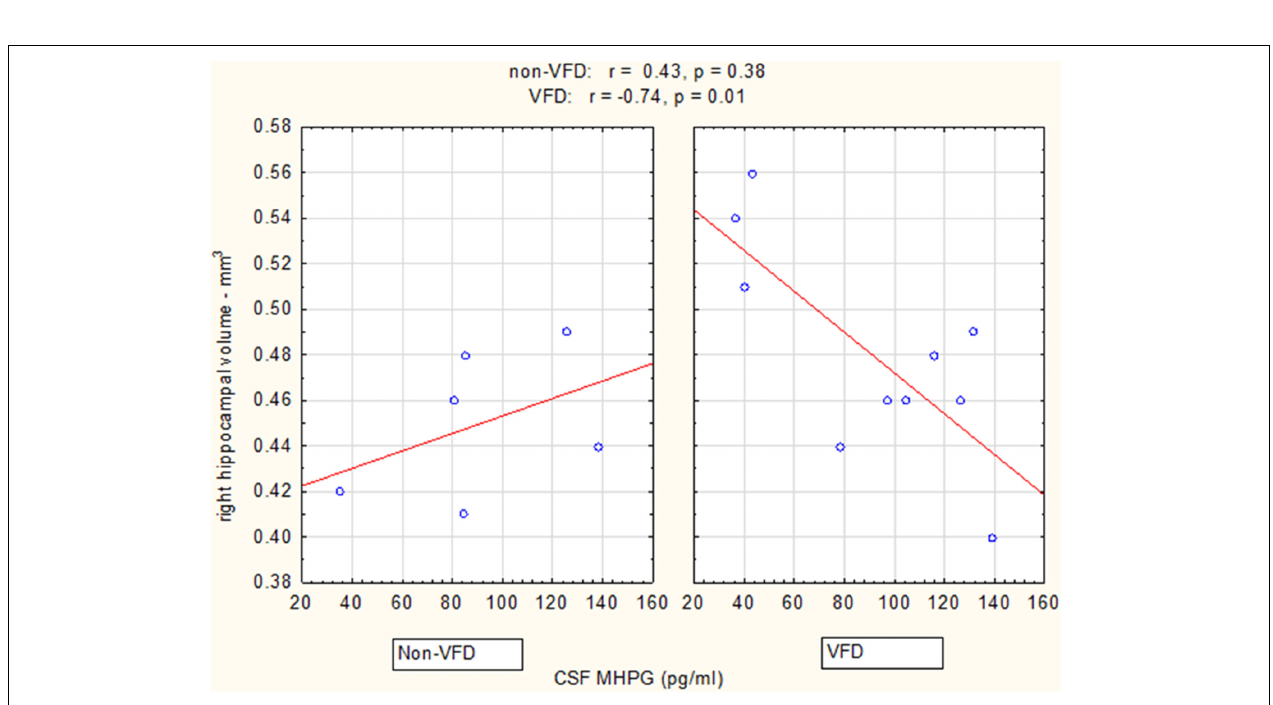
FIGURE 4 | Relationship between right hippocampal volume and CSF MHPG as a function of early life stress. For CSF MHPG, right hippocampus correlated inversely in VFD-reared subjects and but not in